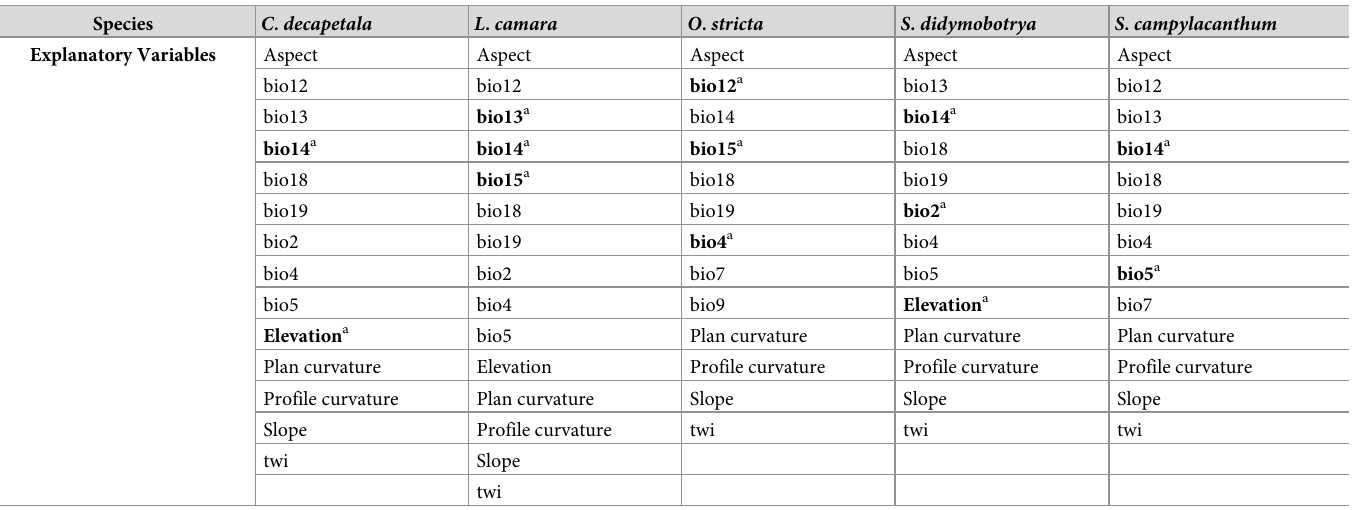
Table 2. Retained noncollinear predictor variables and their relative